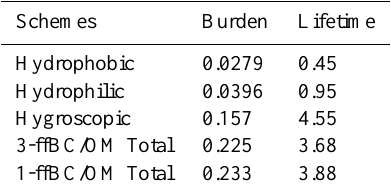
Fig. 2. Frozen fraction as a function of temperature for dust, BC/OM in the original 1-ffBC/OM scheme, and hydrophobic, hy- drophilic, and hygroscopic BC/OM in the new 3-ffBC/OM scheme with hygroscopic soot particles as heterogeneous ice nuclei. Table 2. ffBC/OM burden and lifetime.